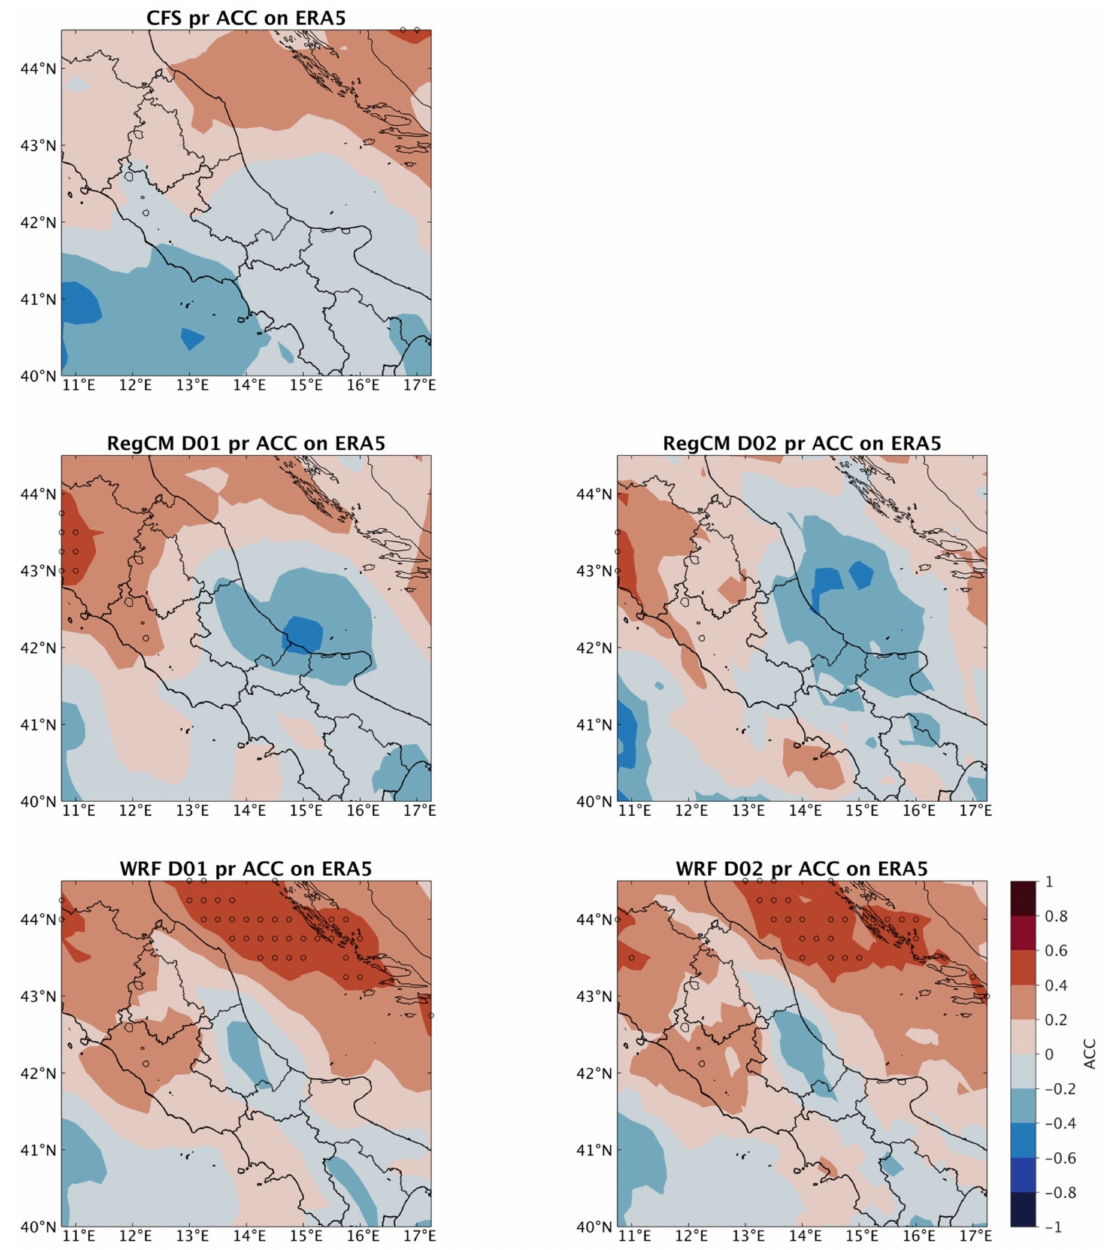
Figure 6. Same as Figure 5 but for the